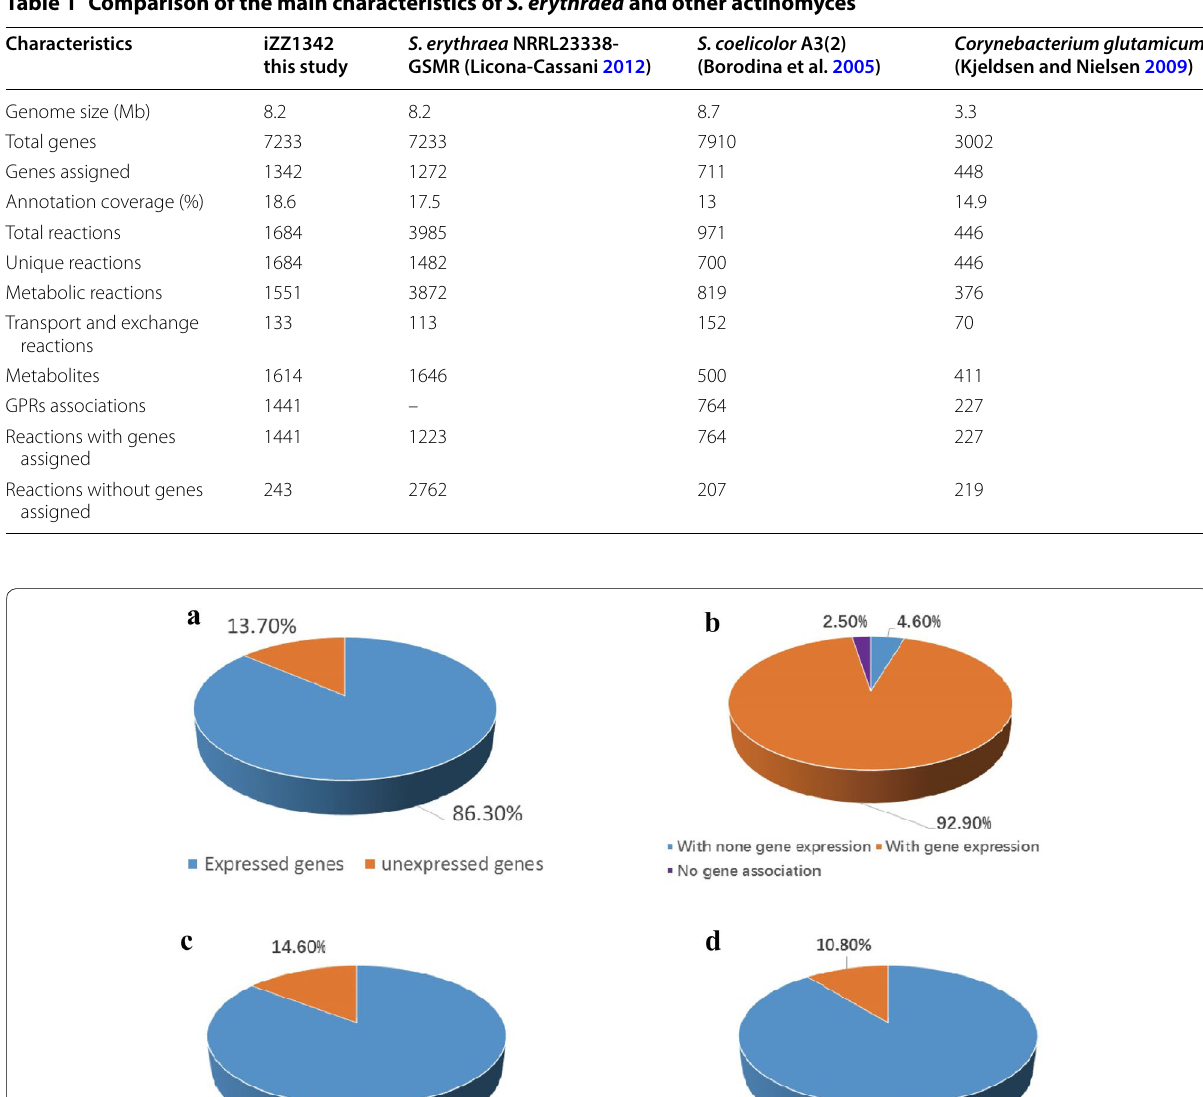
Table 1 Comparison of the main characteristics of S. erythraea and other actinomyces